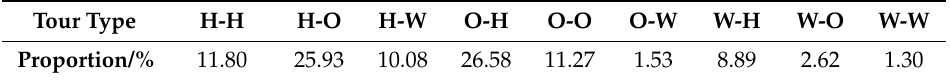
Table 1. The proportion of tour types; H-H: from the residential area to the residential area; H-O: from the residential area to the commercial area; H-W: from the residential area to the industrial area; O- H: from the commercial area to the residential area; O-O: from the commercial area to the commercial area; O-W: from the commercial area to the industrial area; W-H: from the industrial area to the